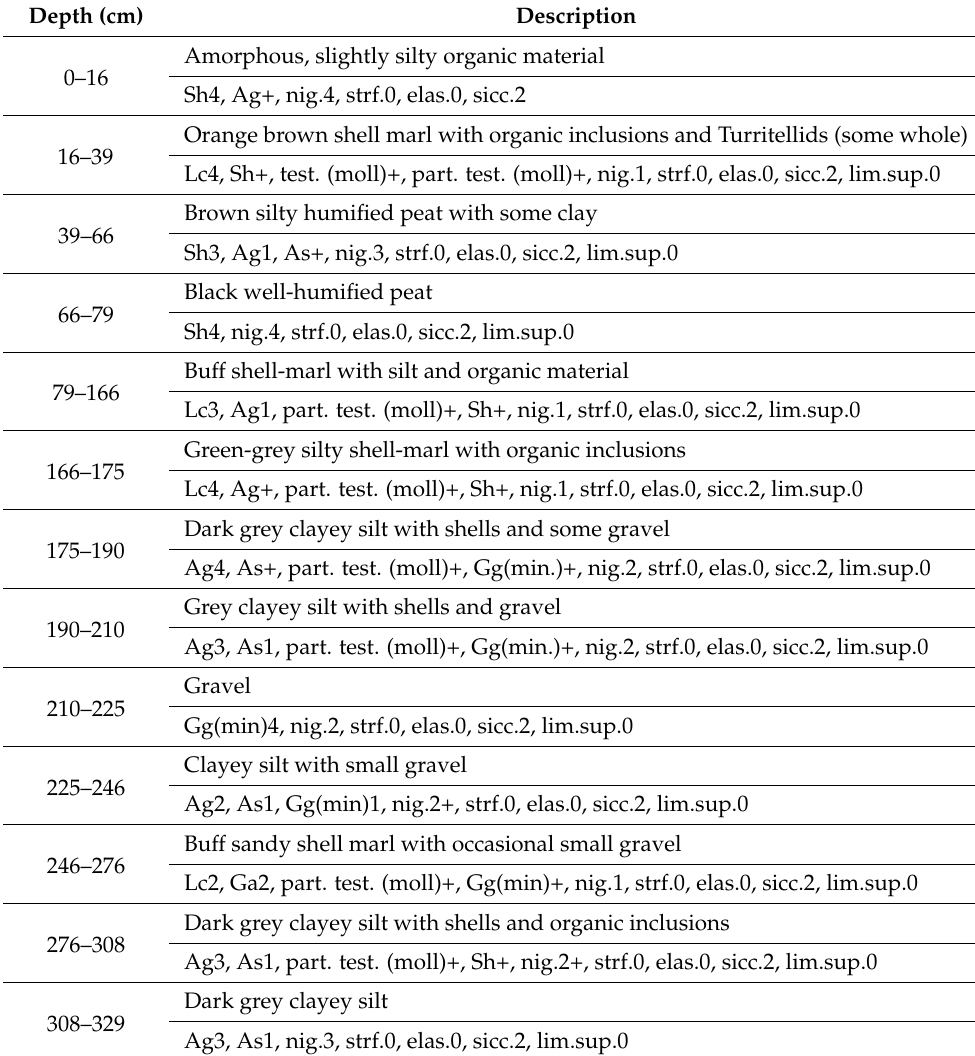
Table 2. Lithostratigraphy at Marfield High Mains Channel. Altitude + 100 m